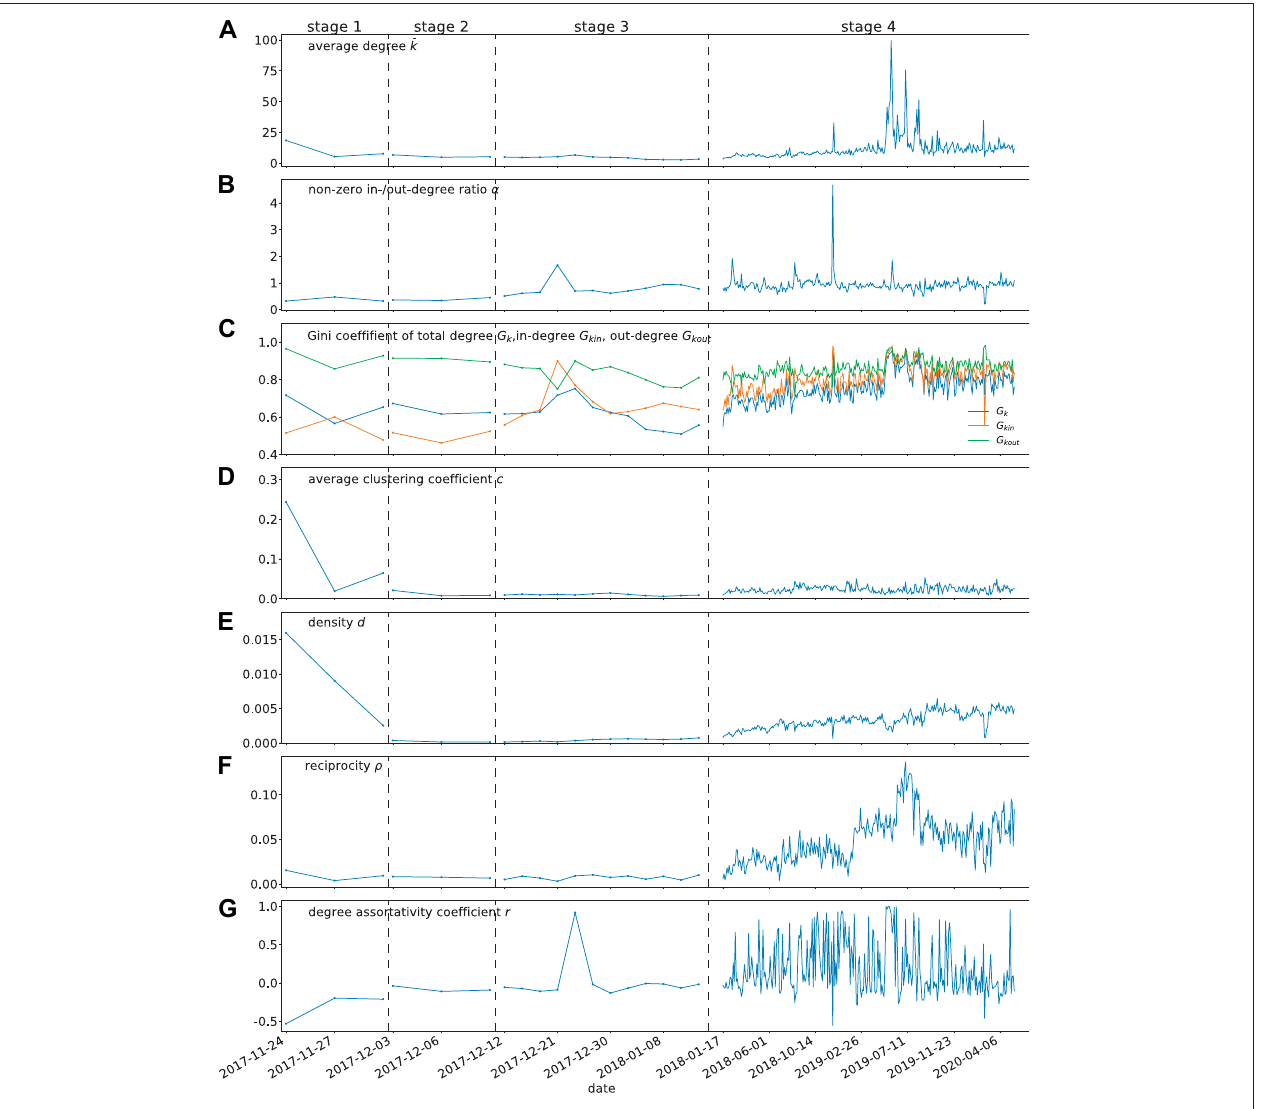
FIGURE 4 | Evolution of the network structural properties over time. (A) The average degree, (B) the non-zero in-/out-degree ratio, (C) the Gini coef fi cients of in-, out-,andtotaldegrees, (D) theaverageclusteringcoef fi cient, (E) networkdensity, (F) reciprocity,and (G) assortativity.Dottedlinesseparatesthefourstages.Thelabels on the x -axis represent the middle date of time windows. The x -axis are re-scaled to better illustrate the parameter dynamics in stages 1, 2 and 3.